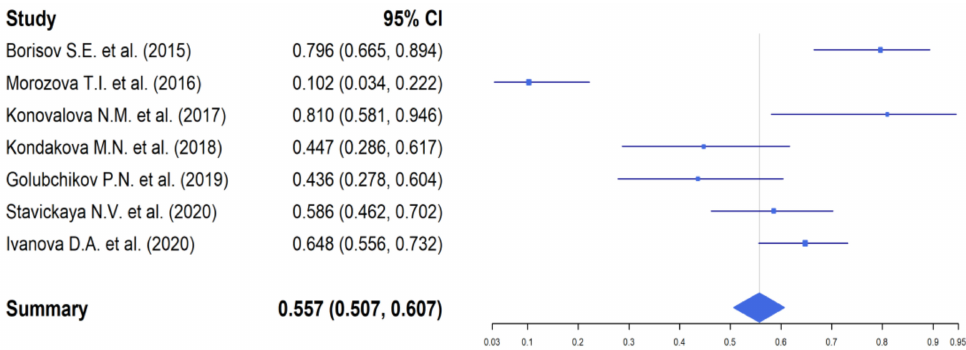
Figure 5. The development of adverse events during therapy with bedaquiline. Borisov et al. [22], Morozova et al. [23], Konovalova et al. [27], Kondakova et al. [28], Golubchikov et al. [31], Stavick- aya et al. [33], Ivanova et al. [34].